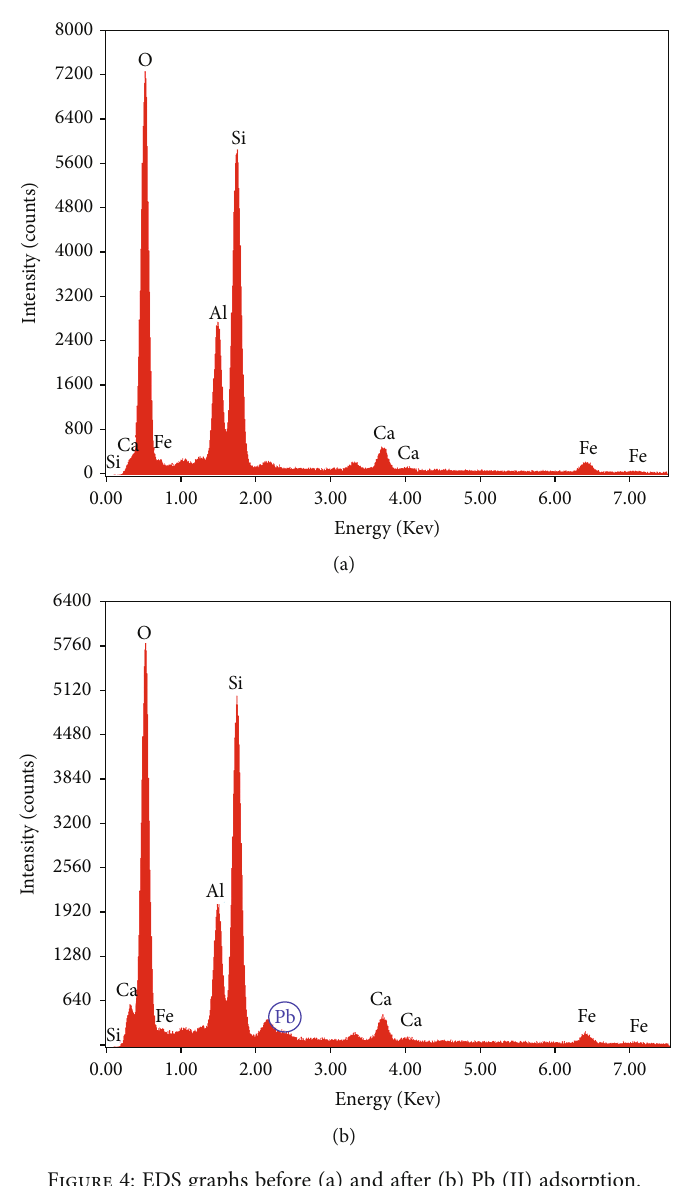
Figure 4: EDS graphs before (a) and after (b) Pb (II)